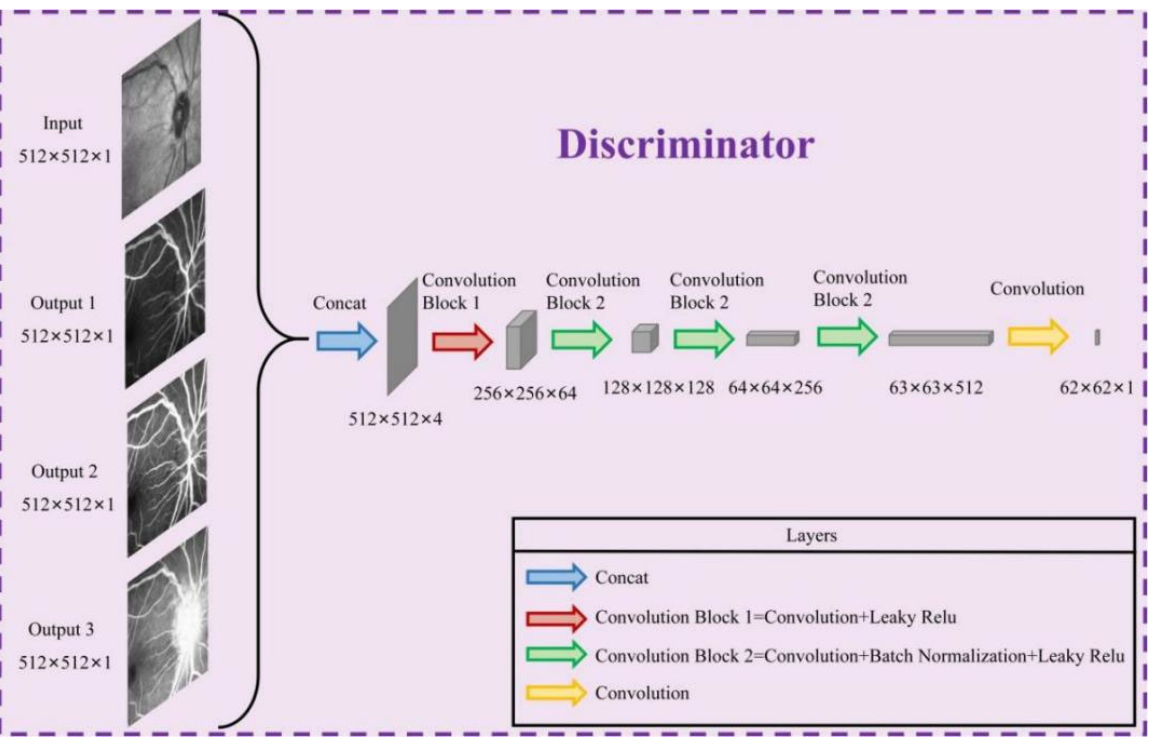
Figure 5. Network architecture of our discriminator.